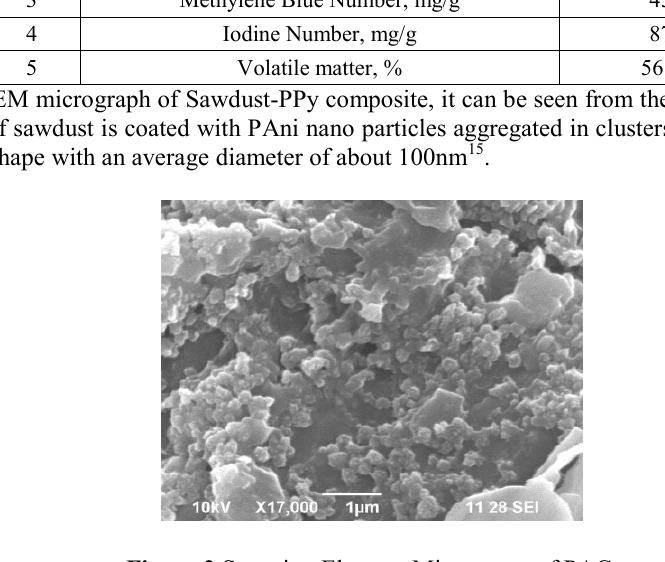
Figure 2 Scanning Electron Microscope of